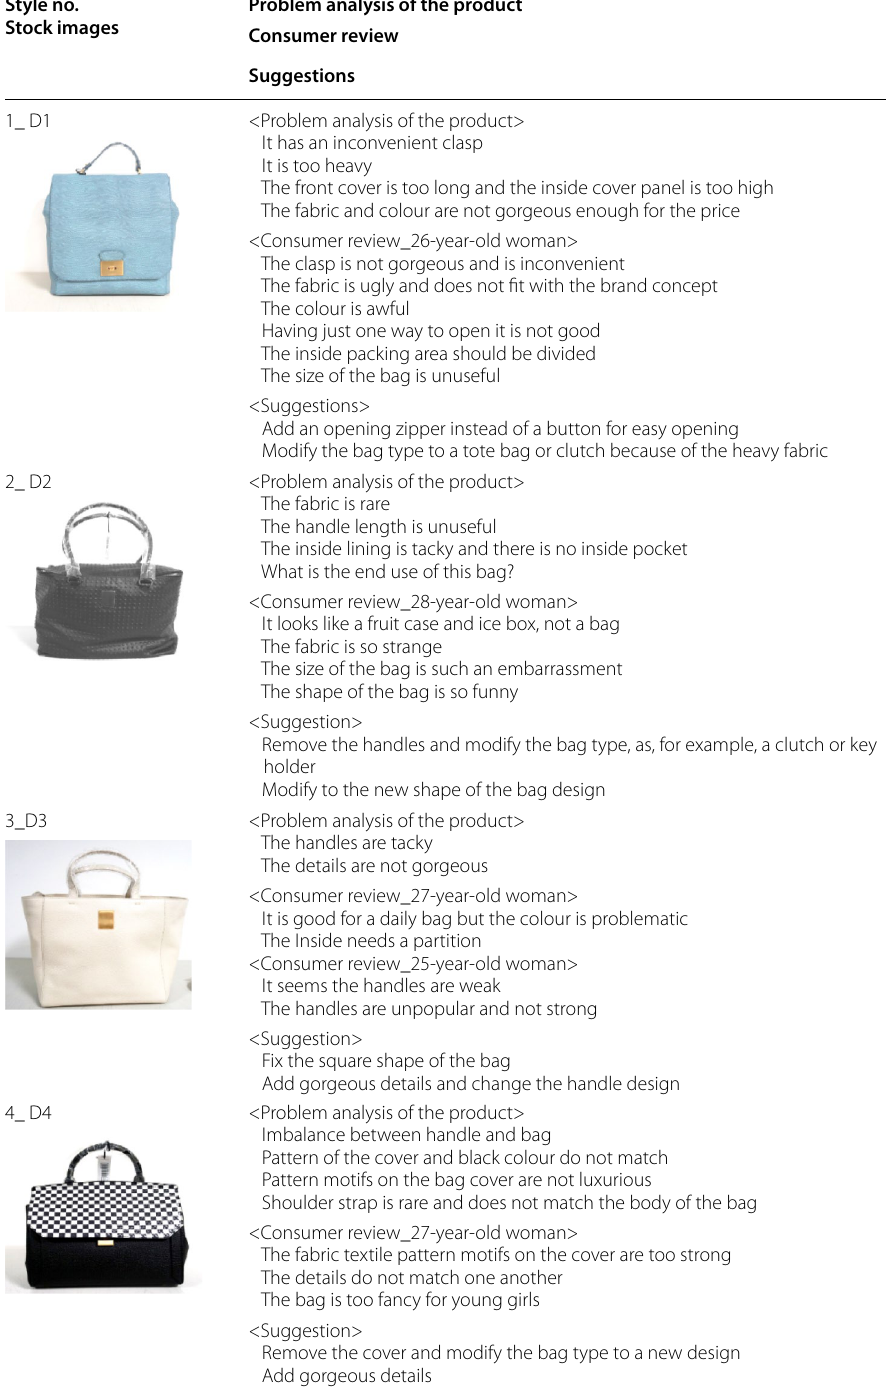
Table 1 Analysis of the products Style no. Stock